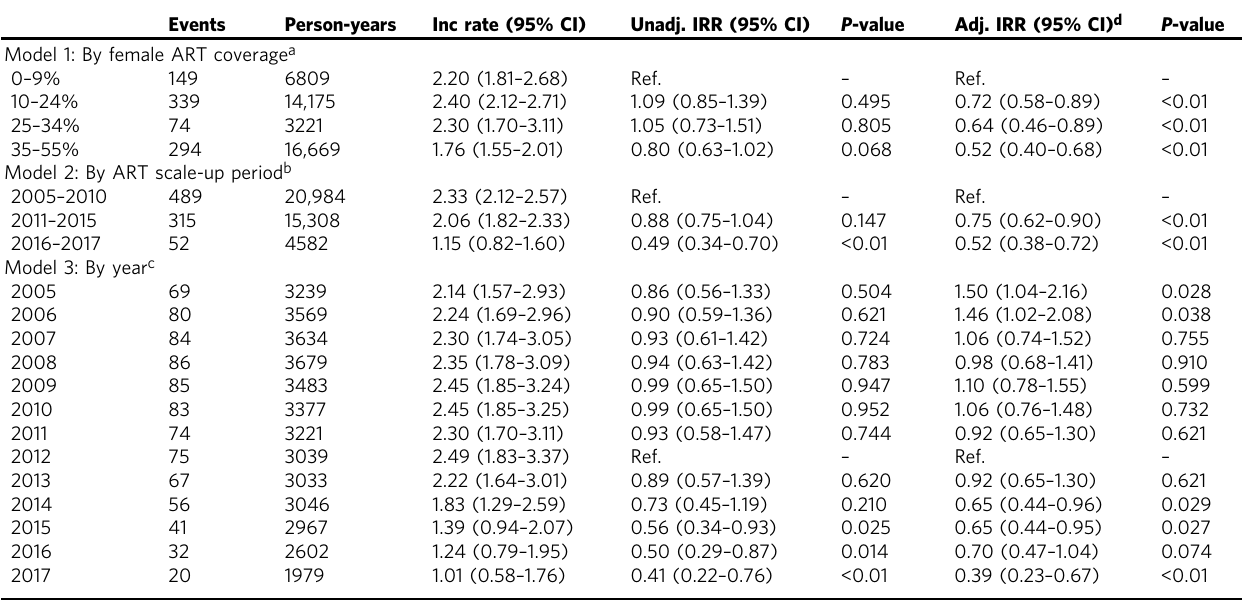
Table 2 Incidence rates (IRs, unadjusted) and incidence rate ratios (IRRs, unadjusted and adjusted) for men ( N = 9630) by female ART coverage, ART scale-up period, and year.